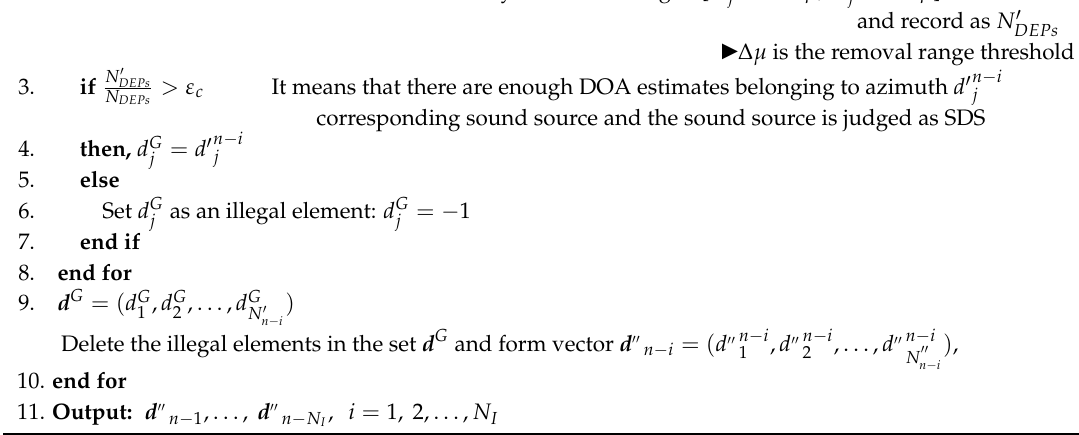
Algorithm 1 : Intra-frame SDS